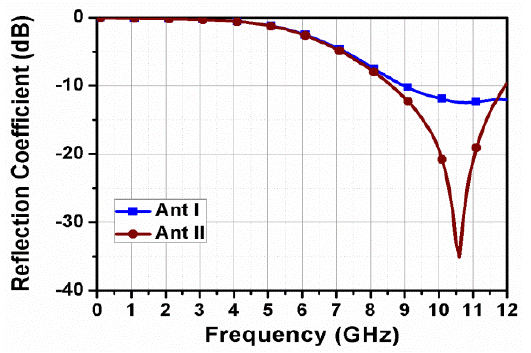
Figure 15. Reflection coefficients of the antennas in intermediate steps of the antenna linked with